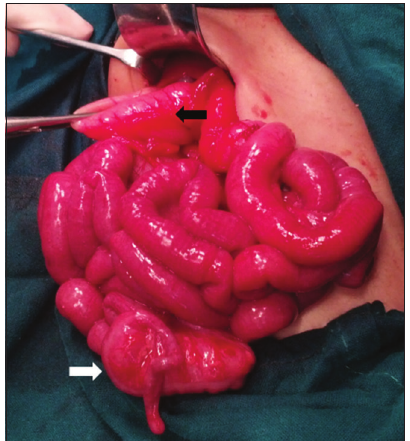
Figure 2: Operative photograph (right supraumbilical incision) showing the subhepatic stomach (black arrow points to greater curvature) and mobile ileocecal region (white arrow)